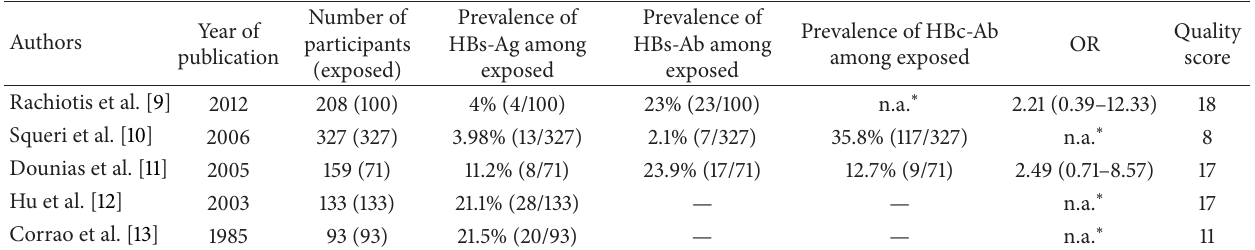
Table 1: Characteristics of the selected studies.